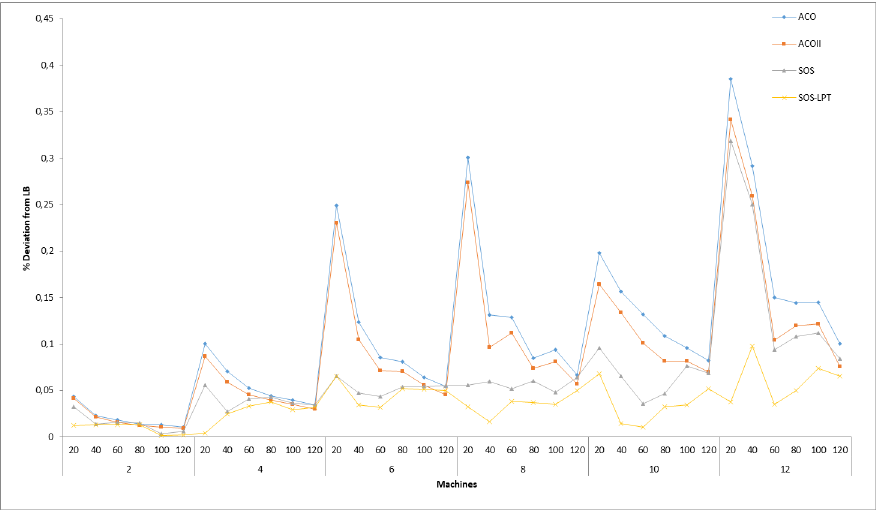
Fig 3. Percentage deviation of each algorithm with LB as the control